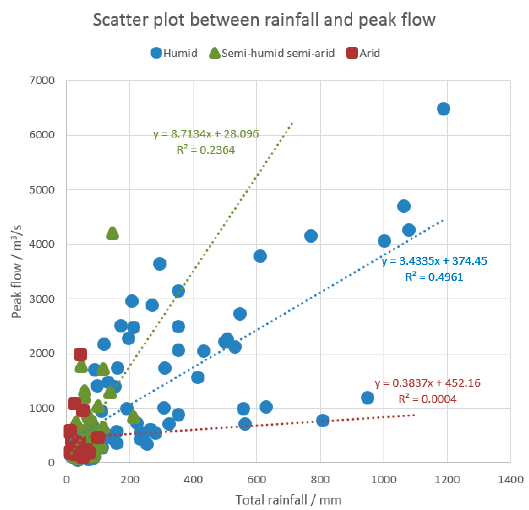
Figure 3. Scatter plot between rainfall and peak flow.